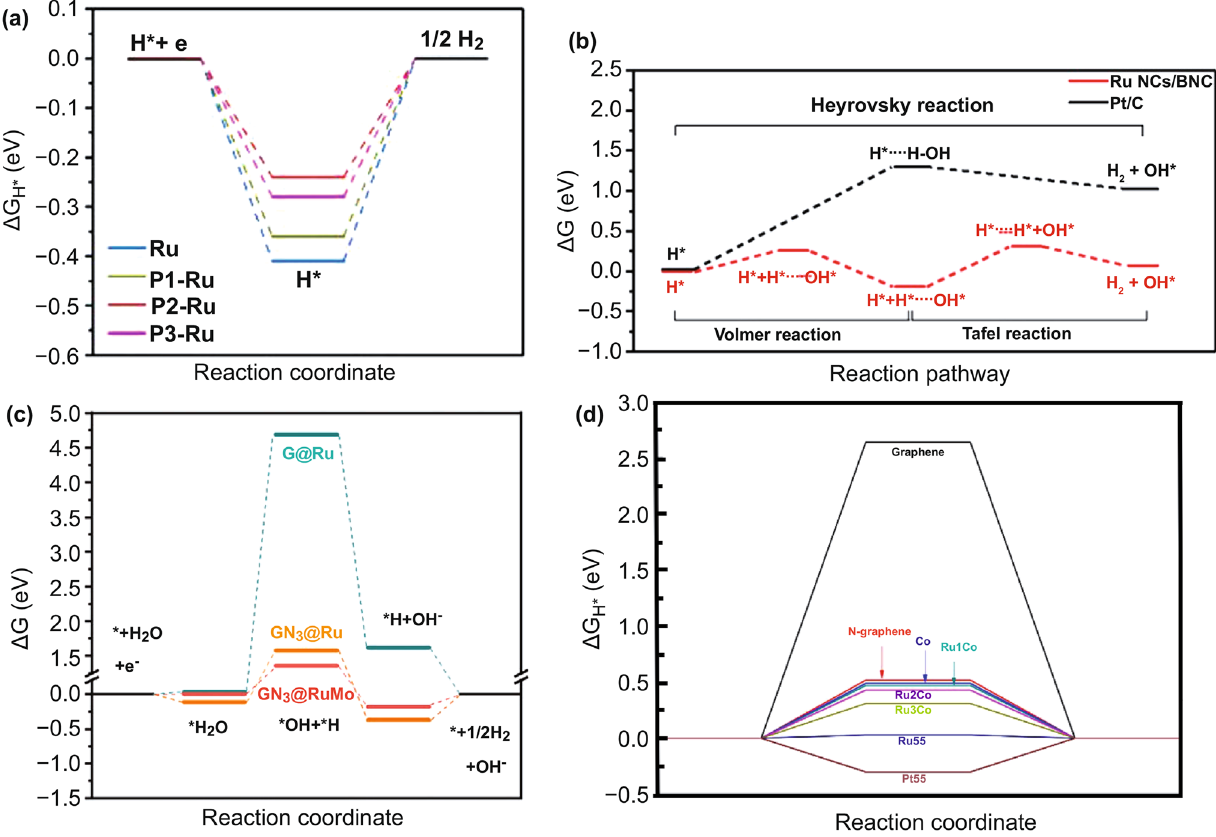
Fig. 2 Effect of different doping strategies on free energy of reaction intermediates: a ΔG H* on Ru, P1-Ru, P2-Ru, and P3-Ru [31], with permis- sion from the American Chemical Society. b Initial, intermediate, and final transition state free energy of Ru NCs/BNC and Pt/C in HER [33], with permission from the Elsevier Ltd. c Free energy of each reaction stage of RuMo alloying [47], with permission from the Wiley–VCH Ver- lag GmbH & Co. KGaA, Weinheim. d ΔG H* value under Co-doped Ru-based catalyst [41], with permission from the Nature Publishing